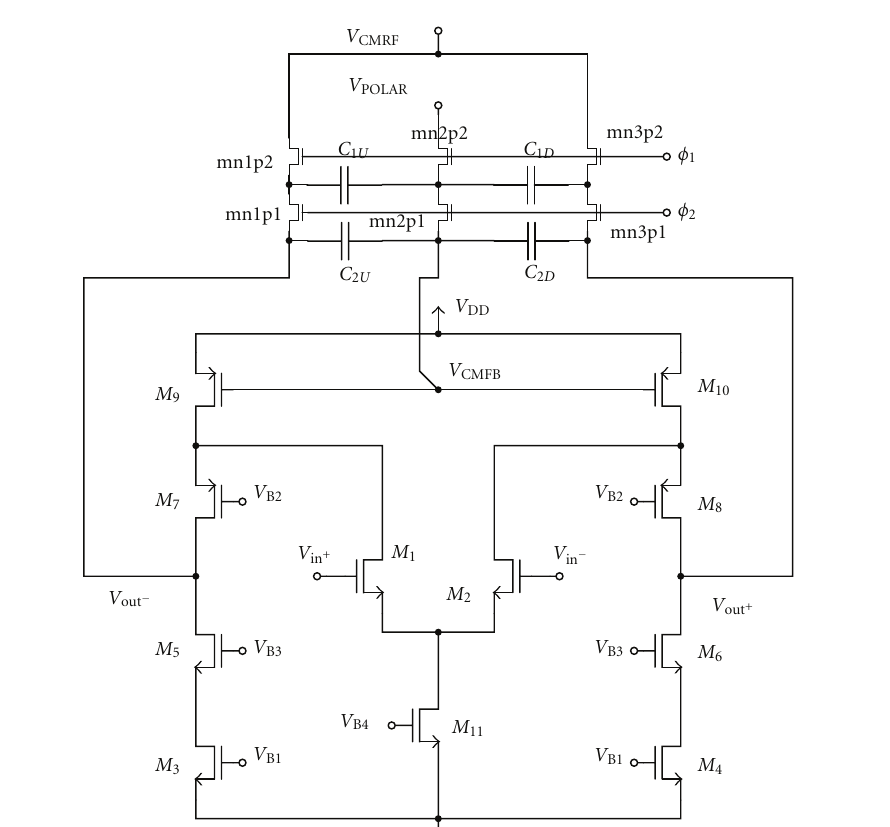
Figure 12: Folded cascode OTA